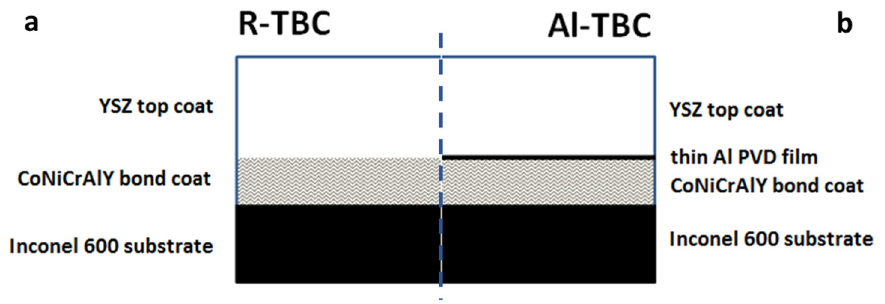
Figure 1. The scheme presents the two TBC systems considered in this work: ( a ) R-TBC—the reference system, and ( b ) Al-TBC—system with an Al interlayer.